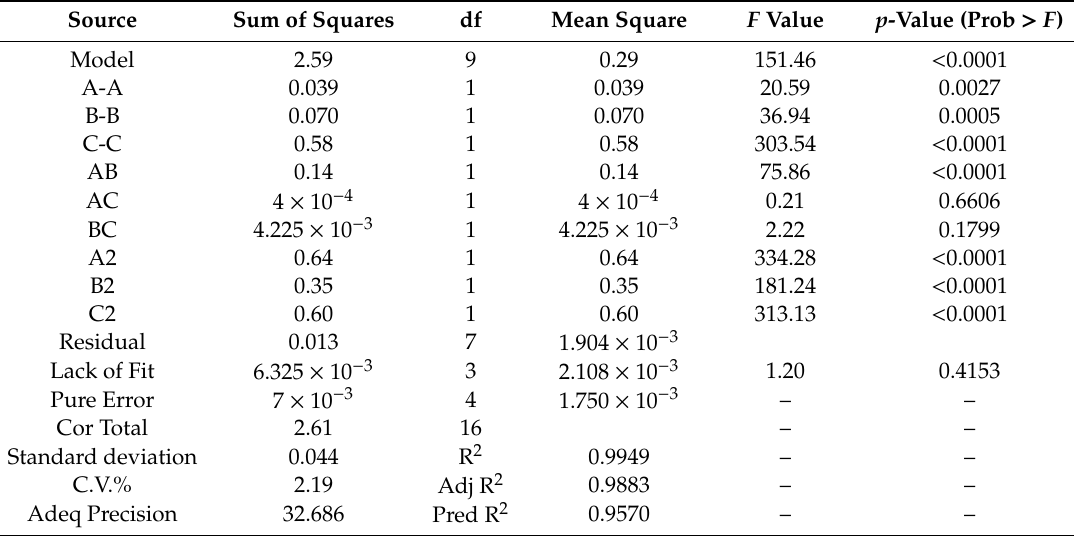
Table 1. ANOVA for the response surface quadratic model.